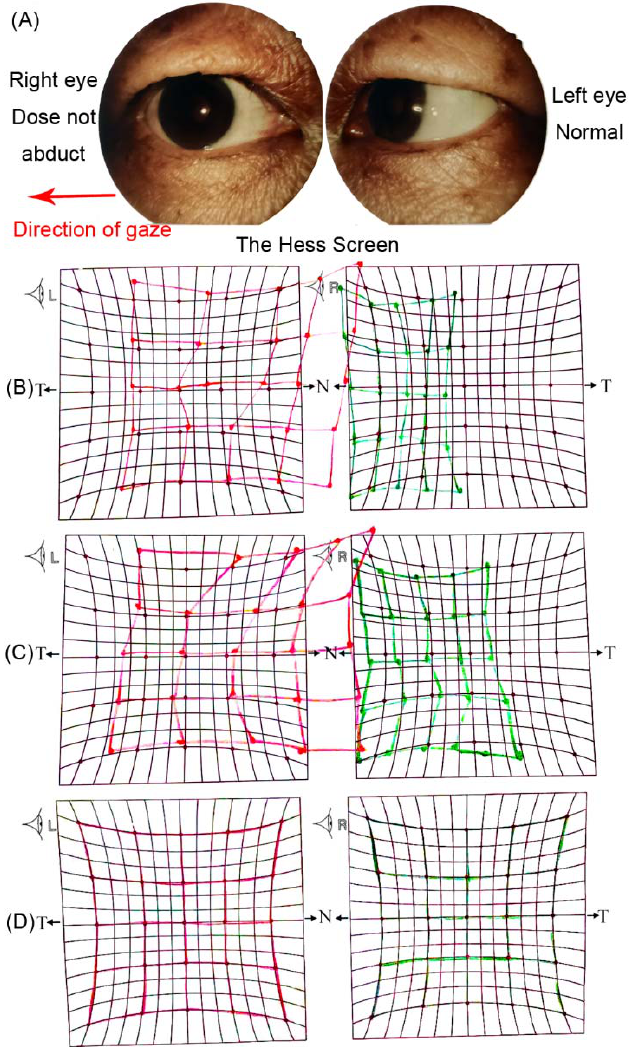
Figure 1. ( A ) The right eye does not abduct when gazing in the right direction. The HESS screen test on the onset days ( B ), one week ( C ), and one month ( D ) after corticoid treatment. T: temporal, N: Nasal.